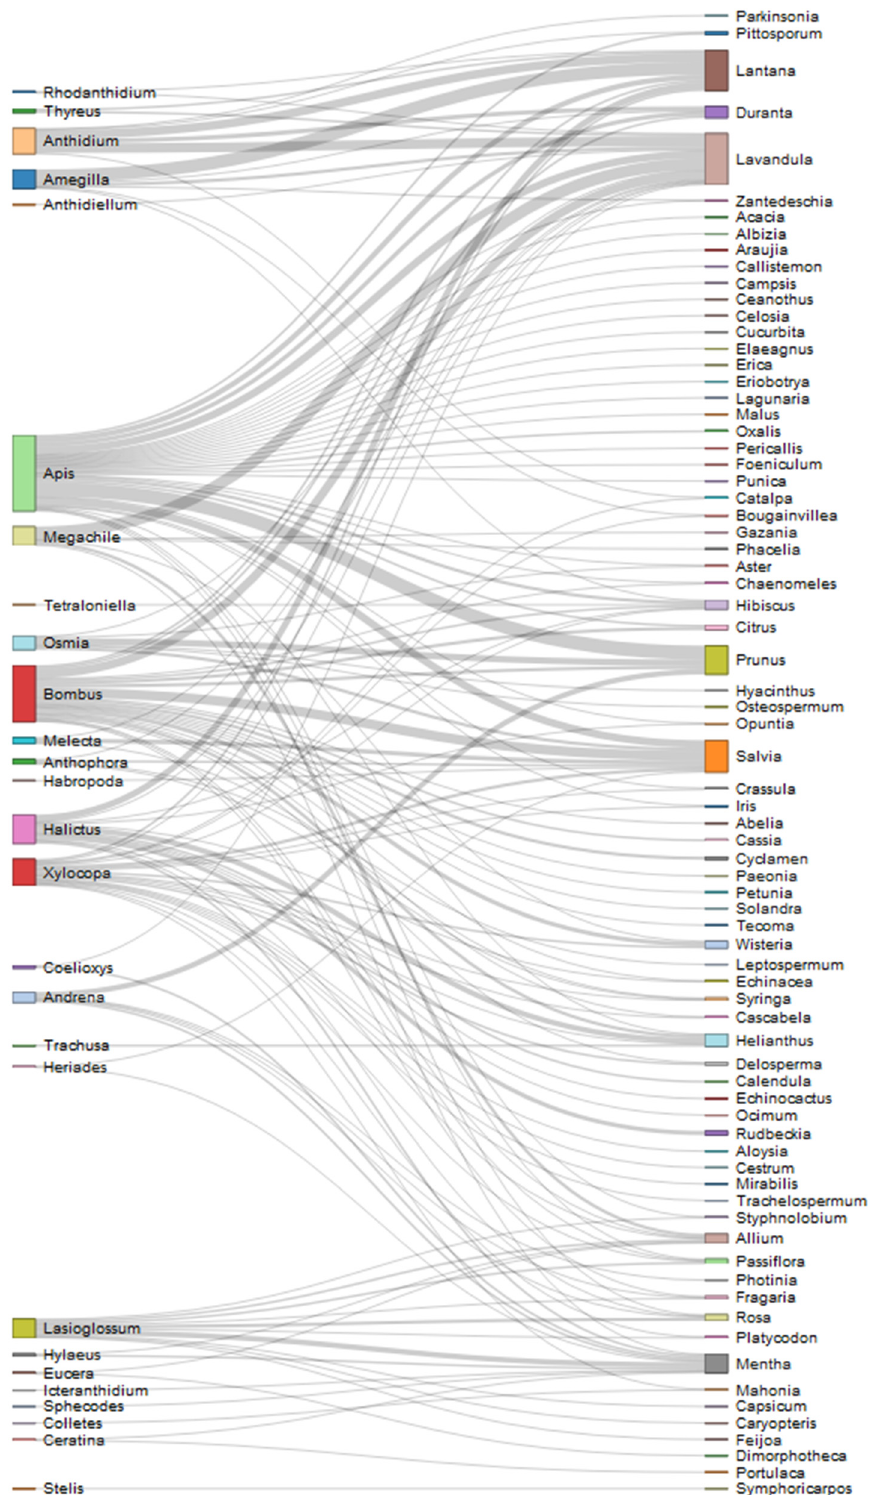
Figure 7. Network of reported interactions between bees and cultivated plants. Genus taxonomic level is considered. On-line interactive version at.